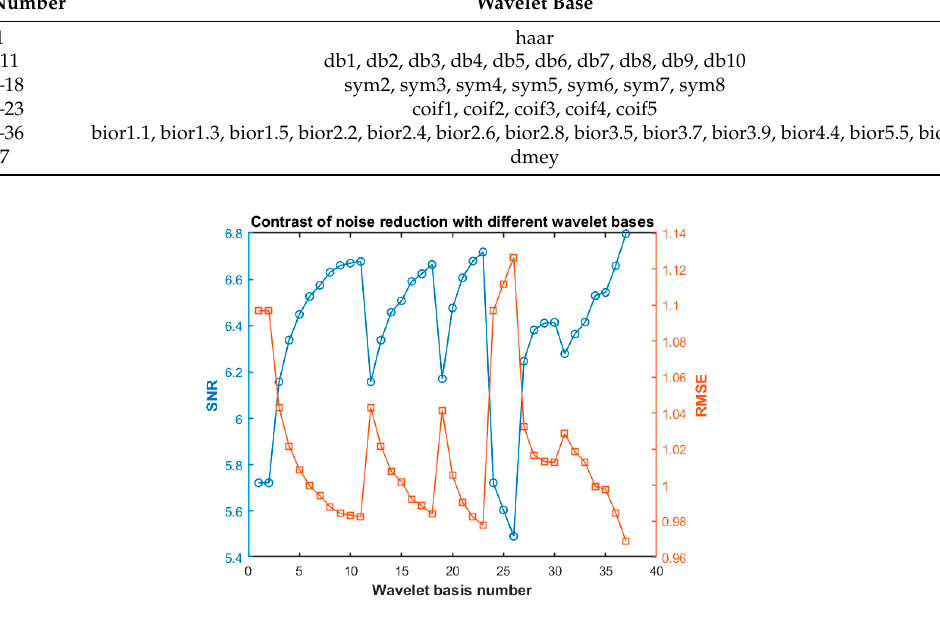
Table 2. Commonly used wavelet bases and corresponding sequence numbers.